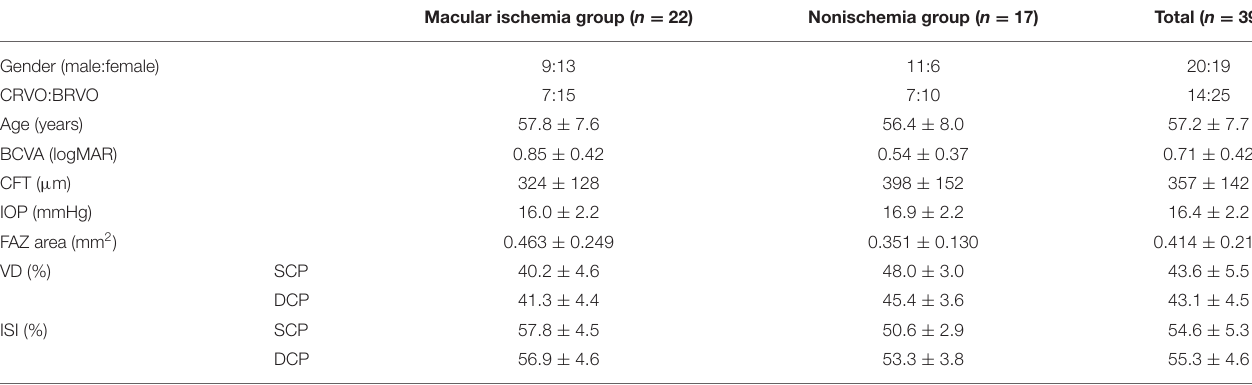
TABLE 1 | Characteristics of the macular ischemia group and the nonischemia group at baseline. Macular ischemia group ( n = 22) Nonischemia group ( n = 17)